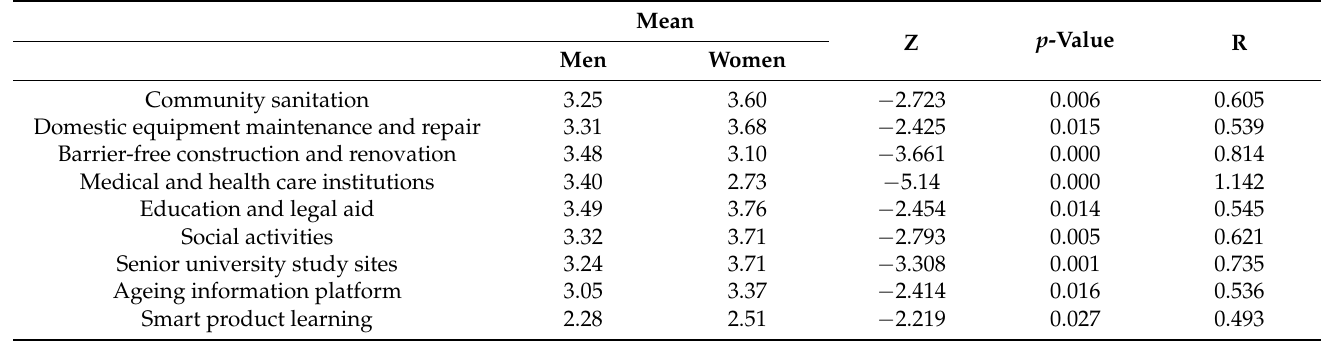
Table 9. Mann–Whitney U test for AFCs’ environmental indicators in terms of gender.